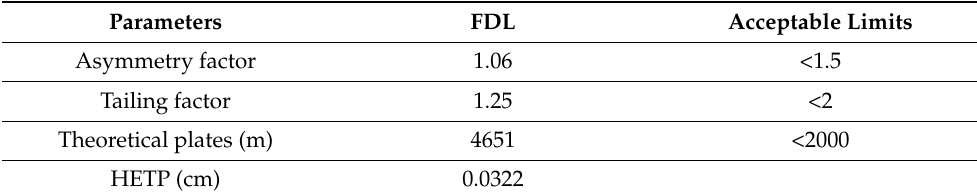
Table 4. System suitability criteria for the determination of fasudil by the HPLC